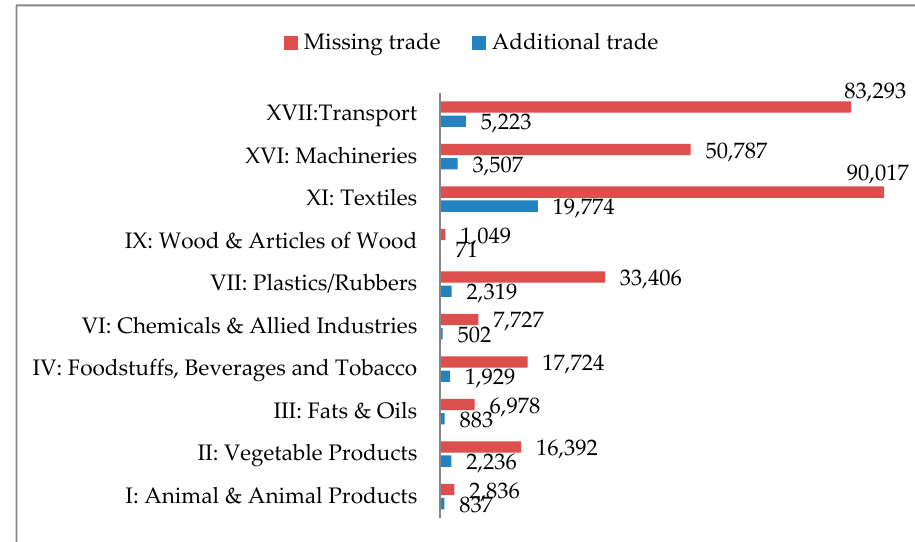
11 of 15 Figure 5. Trade effect due to preference: Results by countries according to regions (CES reference tariff). At world prices; millions of €. Source : Elaboration on data by COMEXT and TRAINS; 2017. Figure 6 shows the trade effect of the actual EU trade policies through the computation of the counterfactual trade flows that would be recorded if all tariffs were removed. The overall protectionist impact of EU trade policies is quite large and amounts to €310,210 million, around 30% of predicted trade. These are imports that would take place under free trade. Larger decrease of trade due to protection is registered for textile products (XI), so that the major exporters of textiles (such as China, India, and Vietnam) should be particularly affected by a liberalization policy. Other sections that might suffer from trade liberalization are the agriculture (Sections I–IV) and the plastic sector (VII). Comparing results so far, notwithstanding the existence of several preferential schemes, the overall stance of the EU trade policy seems to remain quite protectionist. Results show that €37,282 million (around 4% of predicted trade) of imports would disappear